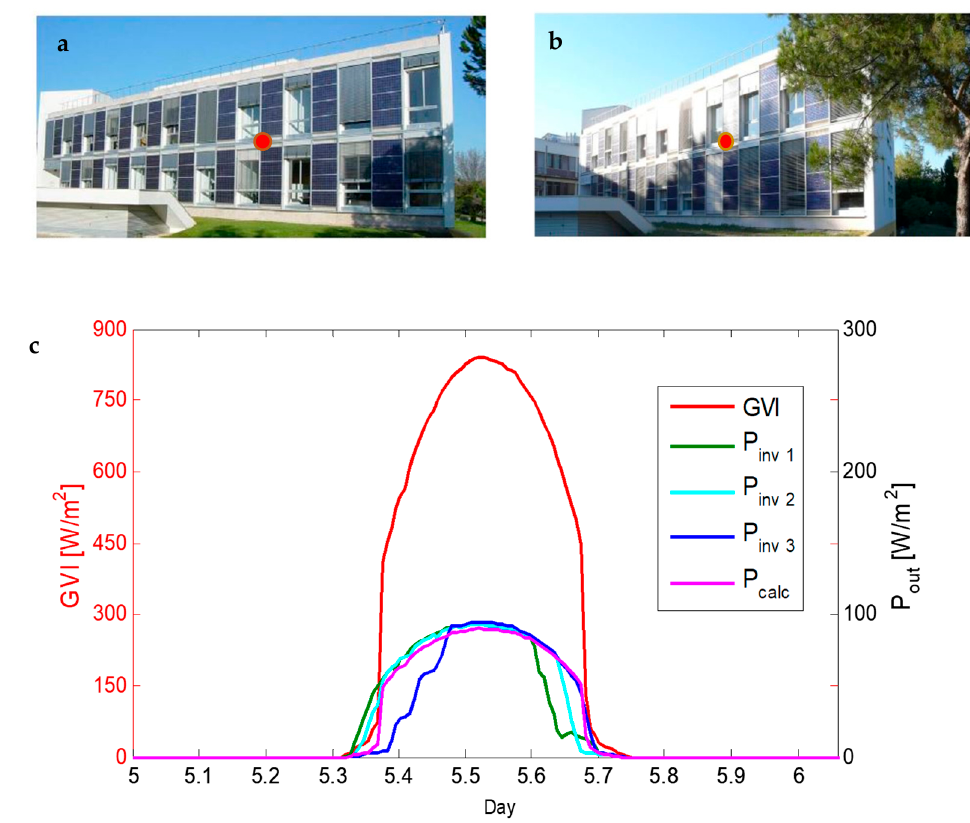
Figure 6. Shadow events in the facade PV system ( a , b ), global vertical irradiation measured in the facade (red dot), and calculated and measured PV production ( c ).